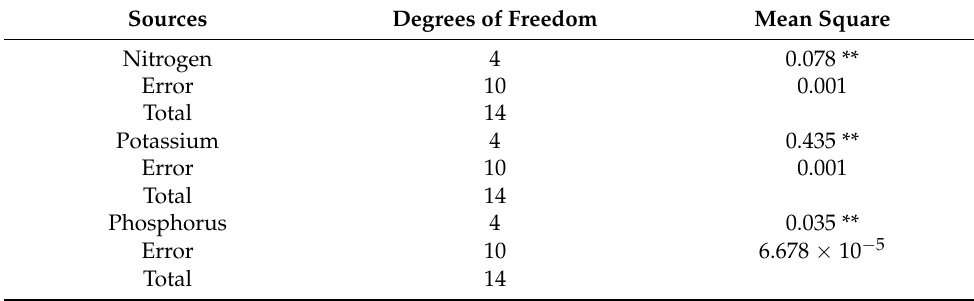
Table 2. Analysis of variance of chemical fertilizer residues in